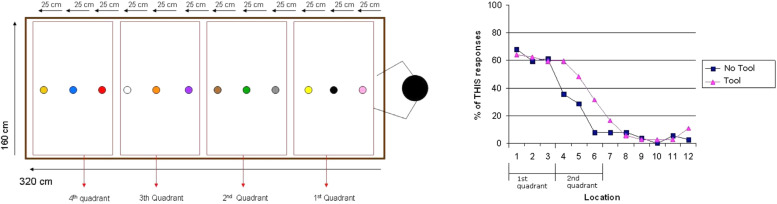
Experimental set-up used by Coventry et al. (2008) (left panel) and associated results (right panel).